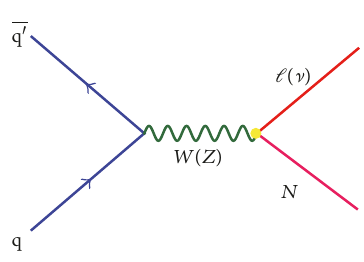
Figure 2: qq 󸀠 ( qq ) process to produce 𝑁ℓ(𝑁 ] ) from the CC(NC)